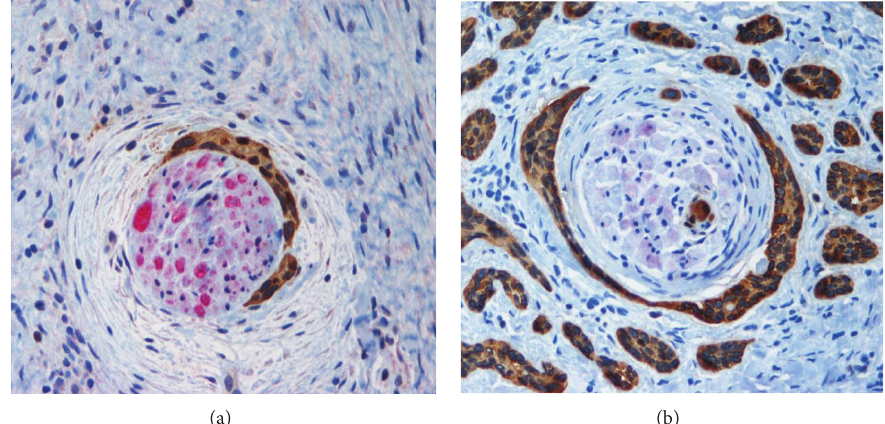
Figure 1: Perineural invasion of squamous cell carcinoma (brown) inside the perineurium of the nerve (red). (a) IHC with dual staining for S-100 and AE1/3, original magnification × 200. Squamous cell carcinoma (brown) surrounding nerve, focally penetrating perineurium, and within fascicles. (b) IHC with dual staining for S-100 and AE1/3, original magnification × 200. IHC: